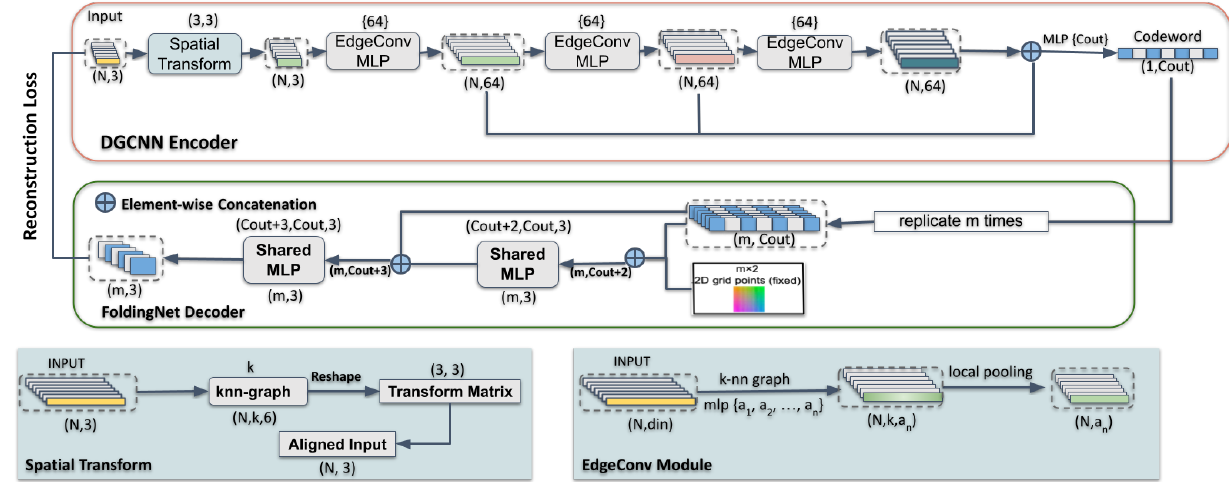
Figure 1 . The architecture of our 3D Autoencoder (AE) network, consisting of a DGCNN-based encoder module (top) and a folding- based decoder module (bottom). The AE learns a discriminative representation “codeword” by reconstructing it to 3D surface and training with Chamfer Distance loss. The outputs of three EdgeConv layers and codeword from pre-trained AE will be further concatenated and used in our semantic segmentation network.